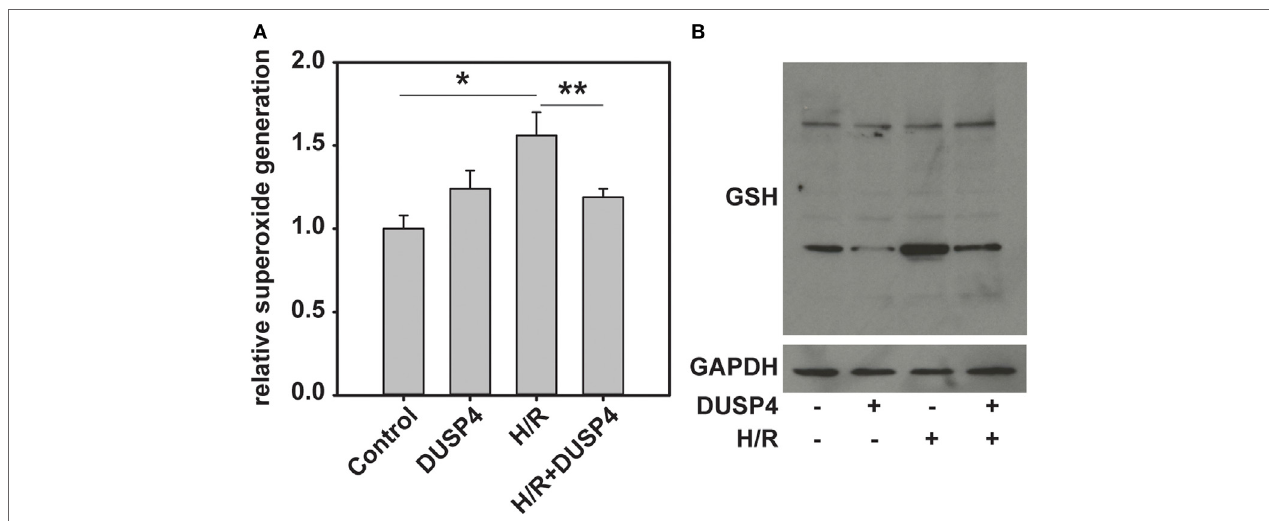
FigUre 3 | Dual-specificity phosphatase 4 (DUsP4) overexpression reduces h/r-induced oxidant stress and decreases total protein s-glutathionylation . (a) H/R induces an increase in superoxide generation from cells (1.0 ± 0.08 versus 1.56 ± 0.14). This increase in superoxide generation inhibited by overexpression of DUSP4 (1.56 ± 0.14 versus 1.19 ± 0.05). * and ** P < 0.05. Data are expressed as mean ± SEM, n ≥ 3. (B) The level of total protein S-glutathionylation is an indicator of oxidant stress. Overexpression of DUSP4 deceases H/R-induced protein S-glutathionylation in bovine aortic endothelial cells. Upper panel is the immunoblotting against GSH. Lower panel is the immunoblotting against GAPDH as a loading